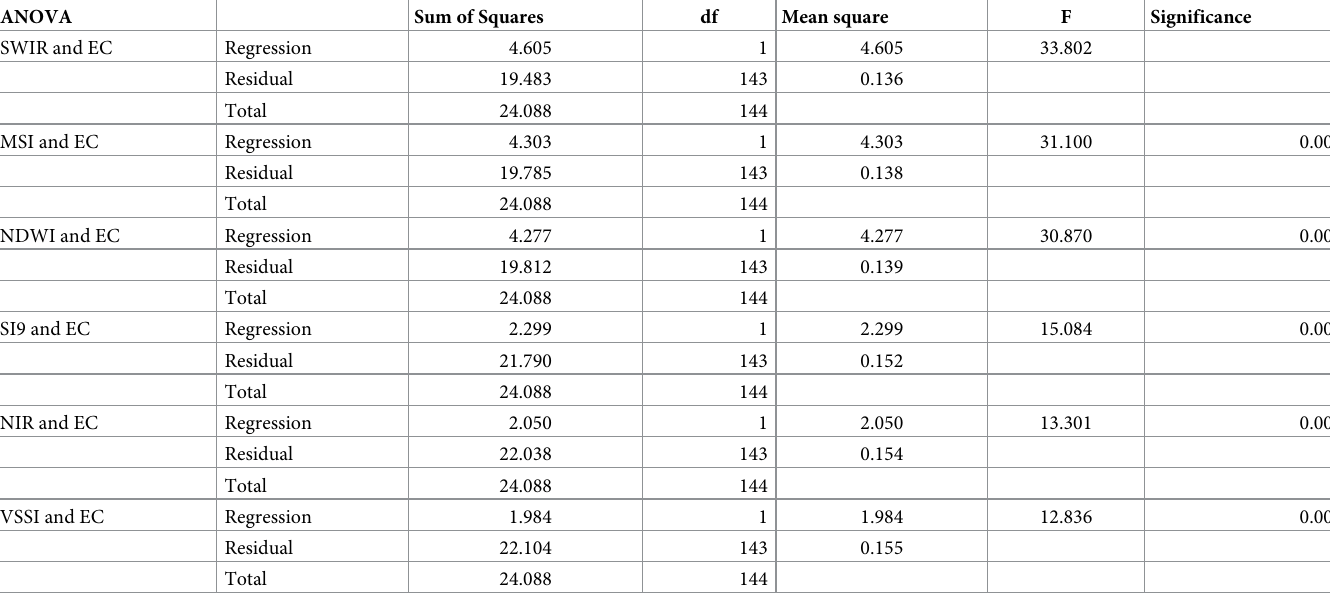
Table 7. The results analysis of variance for linear regressions.